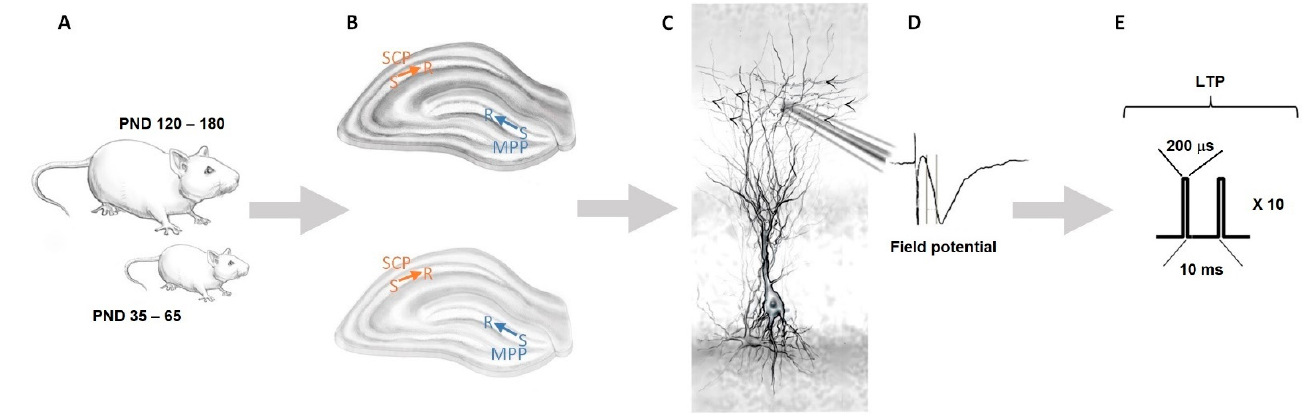
Figure 1. Diagram of the experimental setting for slice electrophysiology. ( A ) Age-specific effects of CholinomiRs interplay in CNS were addressed by comparing responses of adolescent mice (PND 35–65) and adult mice (PND 120–180). ( B ) Illustrations of hippocampal slices from old and young mice. The place where stimulating (S) and recording (R) electrodes were located at the MPP (blue) and SCP (orange) are indicated. Simulation was delivered at the middle inputs coming from the entorhinal cortex molecular layer for recordings at the dentate gyrus and at the CA3 stratum radia- tum layer for recordings at the SCP. ( C ) Graphic detail of an electrode used for recordings positioned at a dendritic zone. ( D ) Illustrative field potential recording. ( E ) Drawing for the pattern of pulses of the electrical stimulation used to induce LTP (see also Materials and Methods). PND: postnatal day; MPP: medial perforant pathway; SCP: Schaffer collateral pathway; LTP: long-term potentia- tion.